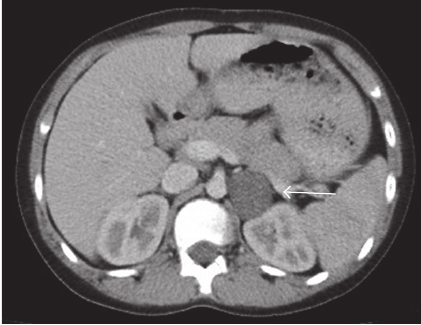
Figure 3: Macroscopic appearance of the tumor. The tumor capsule is smooth and the tumor contains yellow and gelatinous areas as well as hemorrhages.